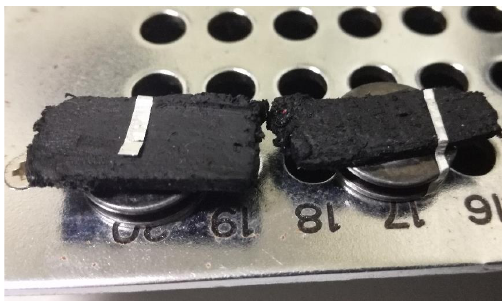
Figure 15. Conductive polymer samples prepared for microscopic analysis.